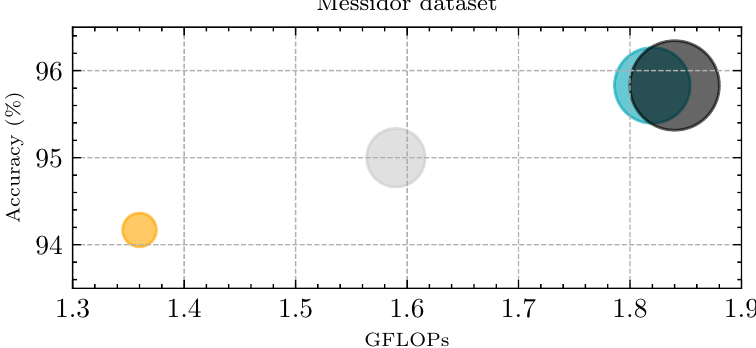
Figure 5. Accuracy-FLOPs curve on Messidor dataset. The circles plotted represent Side branch 1, Side branch 2, Side branch 3, and main branch in order of increasing